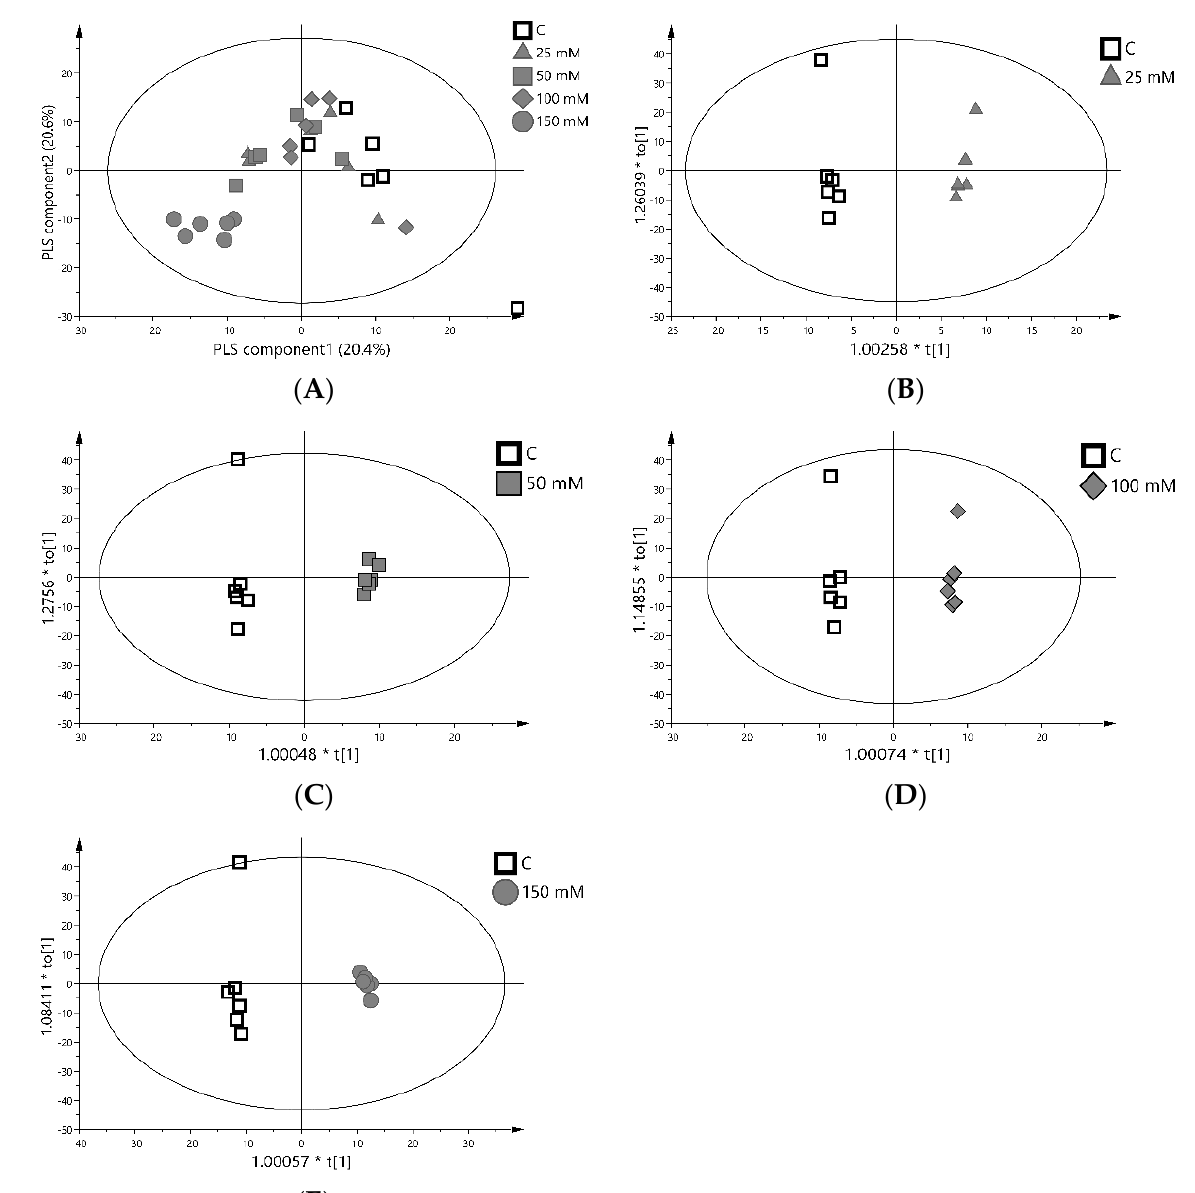
Figure 3. Multivariate analysis of metabolites assayed by GC − MS in gac leaf grown under salinity. ( A ) PLS − DA, ( B ) OPLS − DA of control and 25 mM groups, ( C ) OPLS − DA of control and 50 mM groups, ( D ) OPLS-DA of control and 100 mM groups and ( E ) OPLS − DA of control and 150 mM groups. Each of six biological replicates was individually plotted and the samples were projected onto a bi-plot showing the first two PCs. Each symbol on the plot represents data from 637 metabolites reduced to a single data point defined by the first (PLSC 1 ) and second (PLSC 2 ) PLSC. Samples that have similar metabolite compositions will cluster together while samples that are different will be further apart. The percentage variation explained by each PC is shown in parentheses on each axis. Please note the x-axes were automatically drawn to differing scales and do not allow for a true comparison of the distinction between control and salt treatment across experiments.